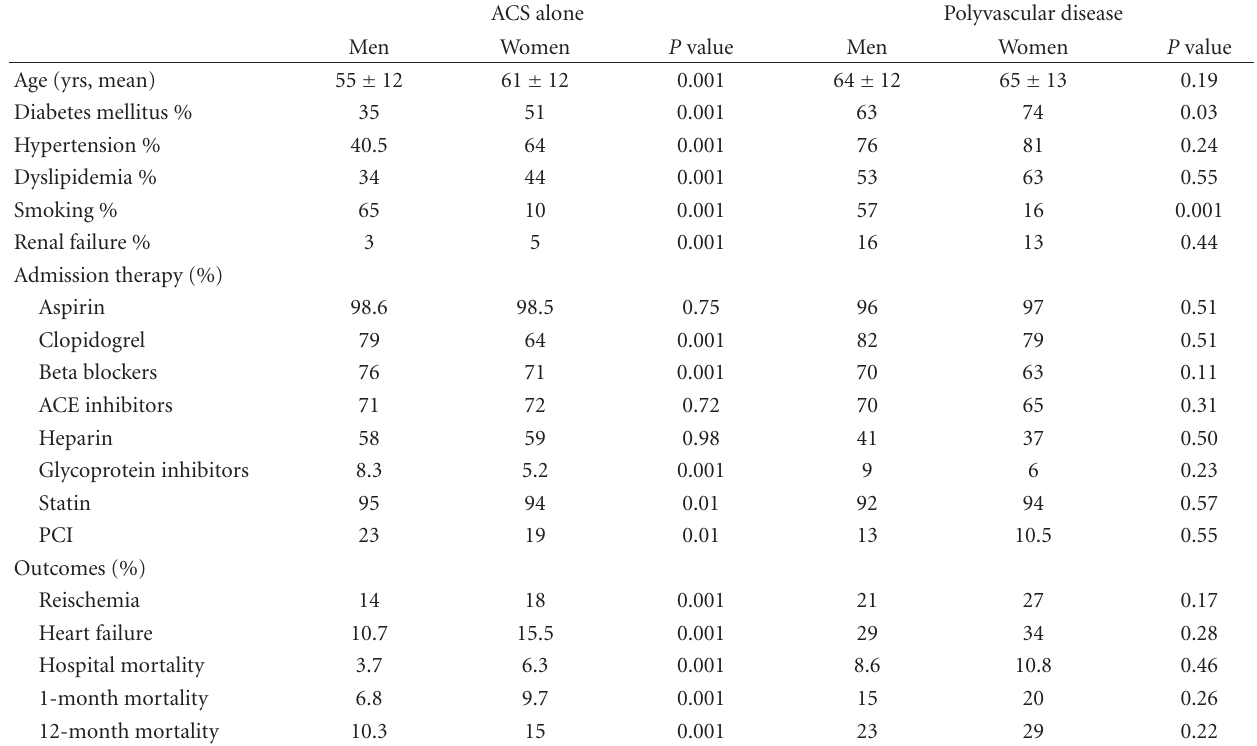
Table 5: Clinical profiles, admission therapy, and outcomes in men and